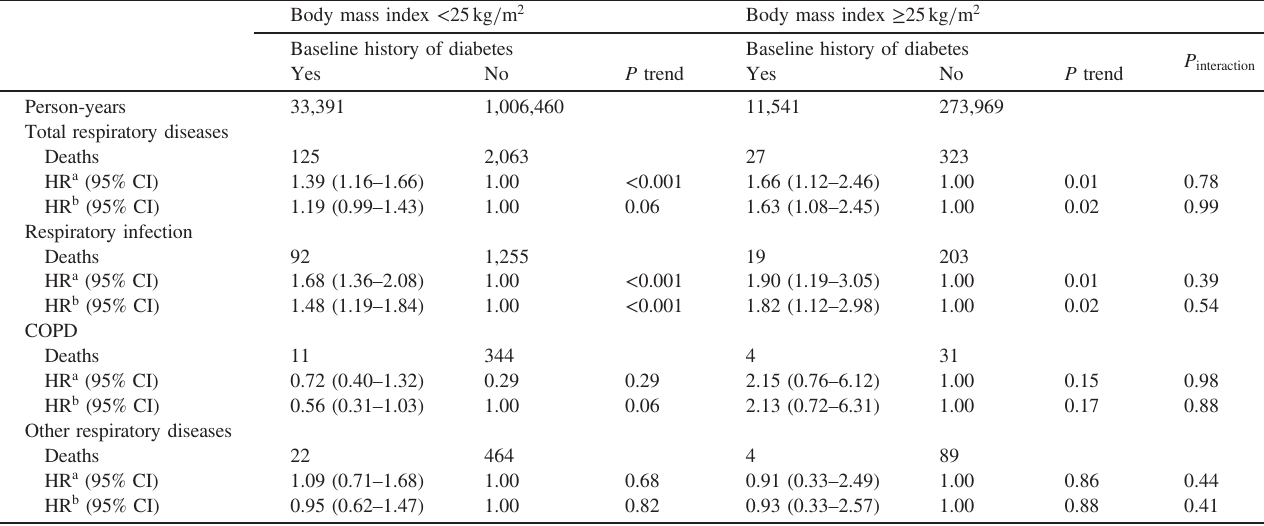
Table 5. Age-adjusted and multivariable hazard ratios (HRs) of mortality from respiratory diseases according to baseline history of diabetes, strati fi ed by body mass